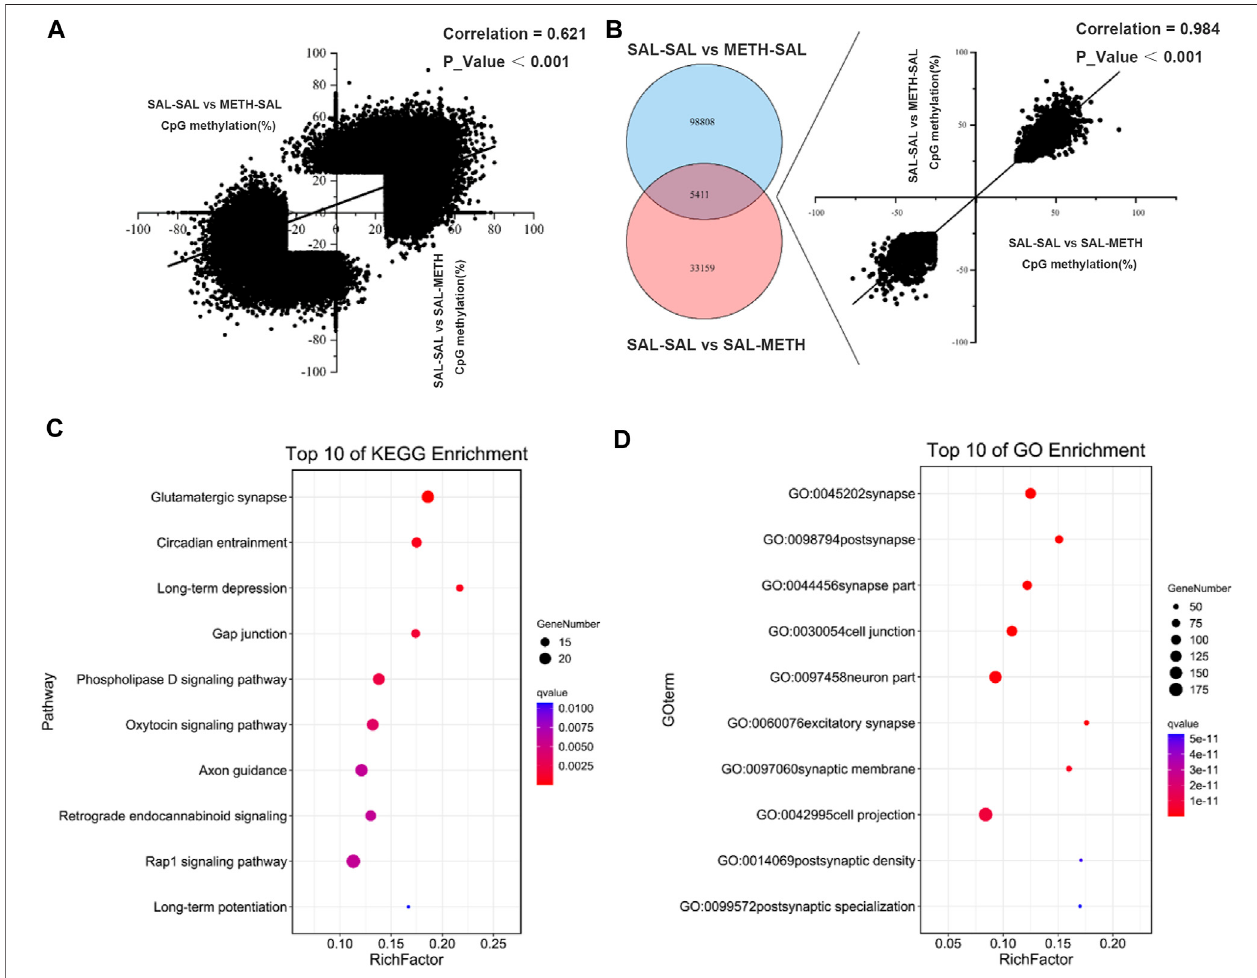
FIGURE 4 | Venn diagram depicting the number of CpGs that are uniquely and commonly affected between prenatal METH exposure and postnatal METH exposure comparison group. (A) A positive correlation of DMCs between prenatal METH exposure and postnatal METH exposure comparison group. (B) 5,411 commonly methylated CpGs (co-methylated) affected by prenatal METH exposure and postnatal METH treatment and show a signi fi cant positive correlation. (C) Top 10 pathway enrichment results of co-methylated CpG localized genes. (D) Top 10 cellular components of GO enrichment results of co-methylated CpG localized genes. Hypergeometric distribution test was used. Data in each group are based on n =